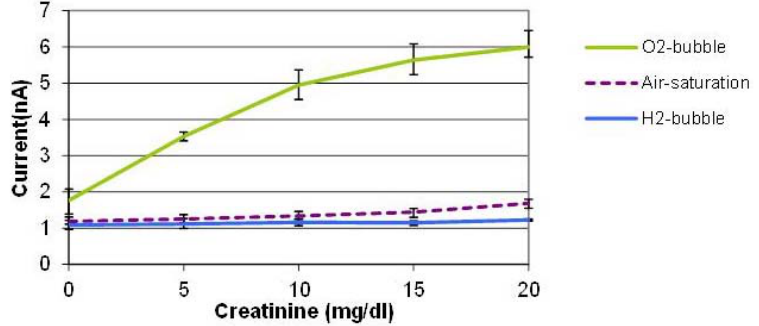
Figure 5. Sensor signal versus creatinine concentration (read at 80 s). The creatinine solutions were saturated or depleted of oxygen by bubbles in fluidic channel at optimized final distance of 1 mm and current density 5.5 mA/cm 2 (n = 9, error bars =